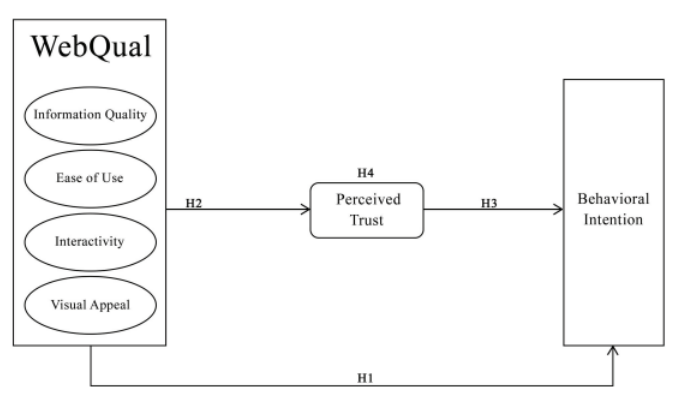
Fig. 1. Research Conceptual Model